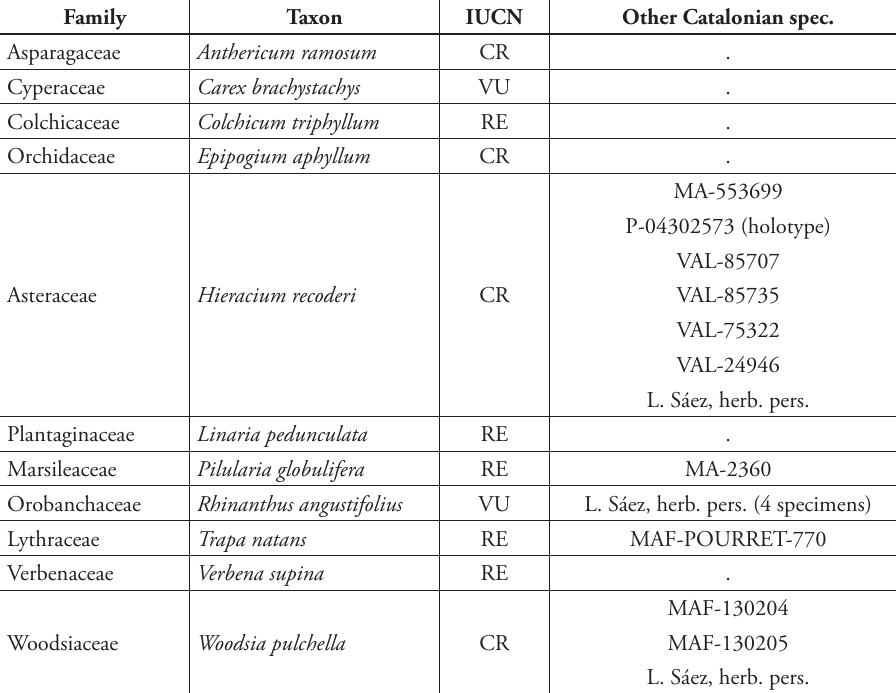
Table 5. Taxa without specimens in the herbaria included in the dataset. Catalonian specimens in other herbaria are